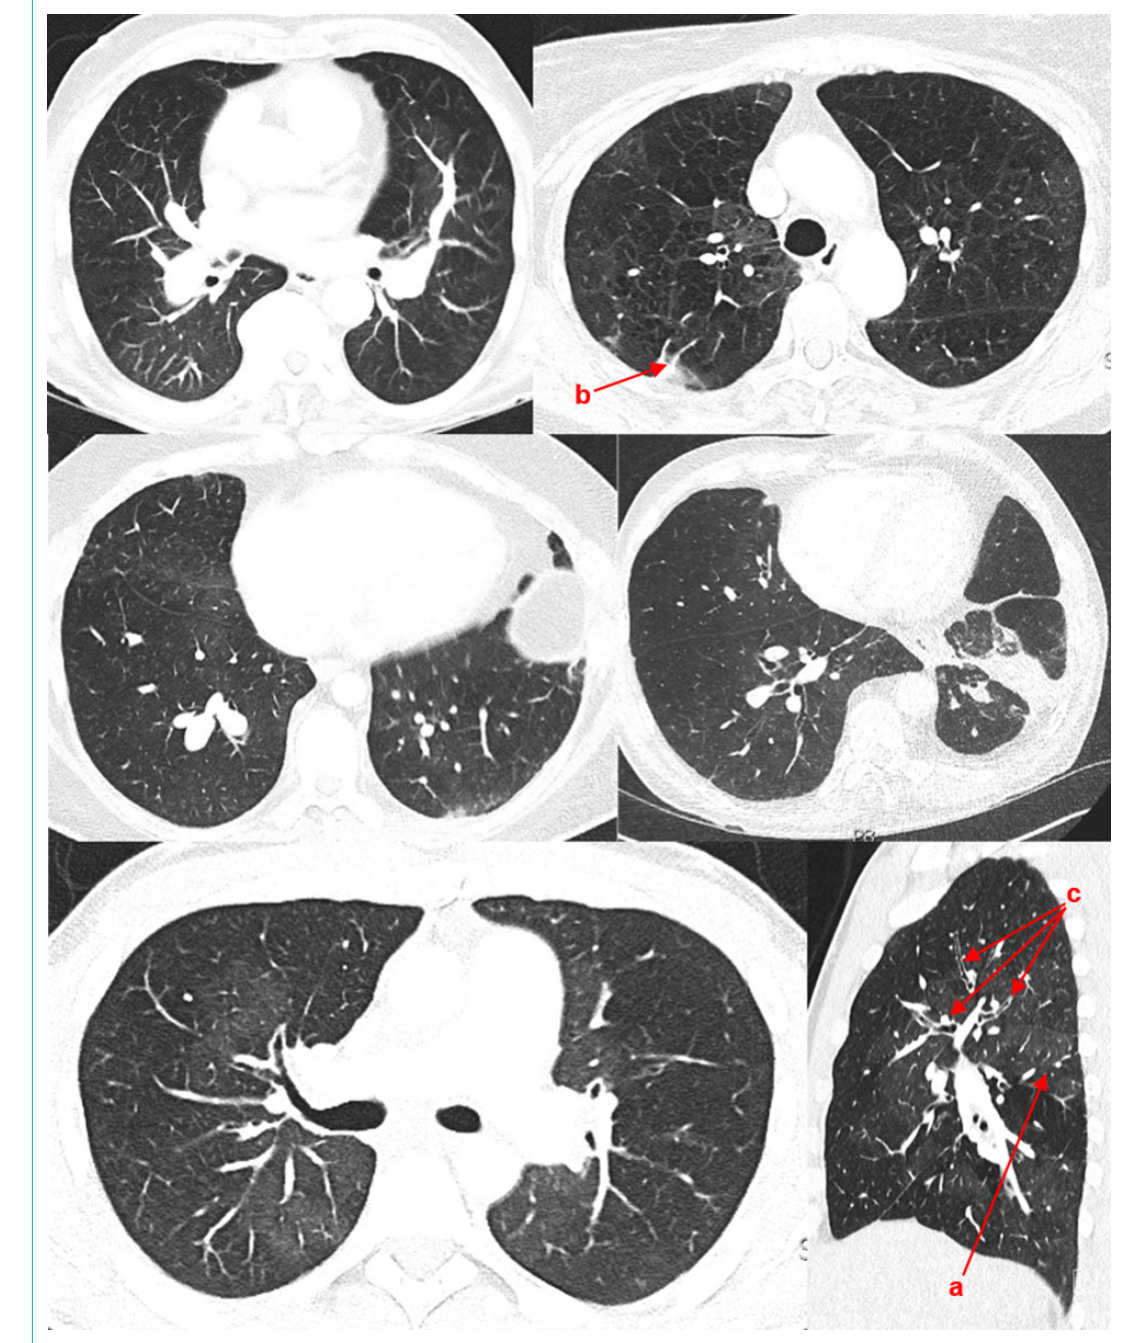
Figure 10: Parenchymal characteristics on computed tomography. (a) Mosaic pattern; (b) pulmonary infarctions; (c) bronchial dilatation / ipsi- lateral bronchiectasis. (Courtesy of Prof. T.